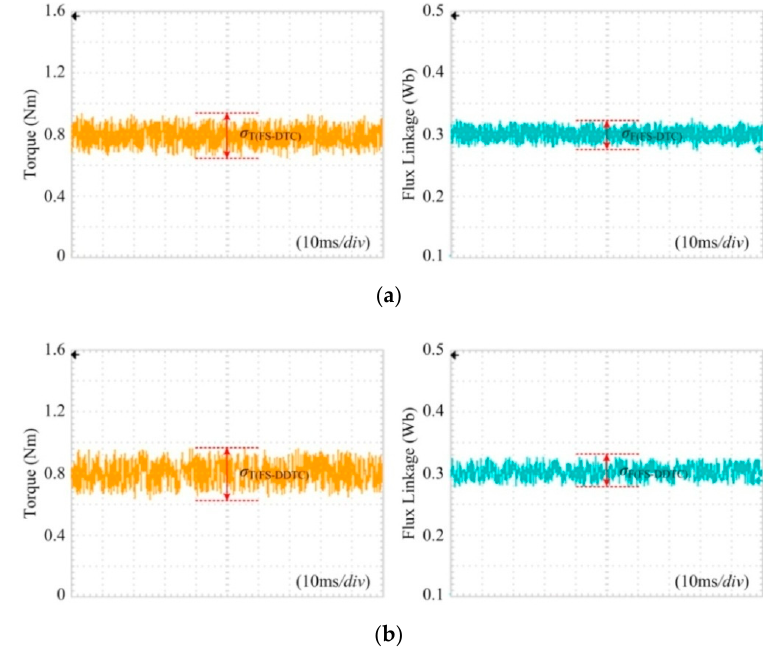
Figure 7. Experimental torque and flux linkage of the PMSM when using: ( a ) FS-DTC; ( b ) FS-DDTC.